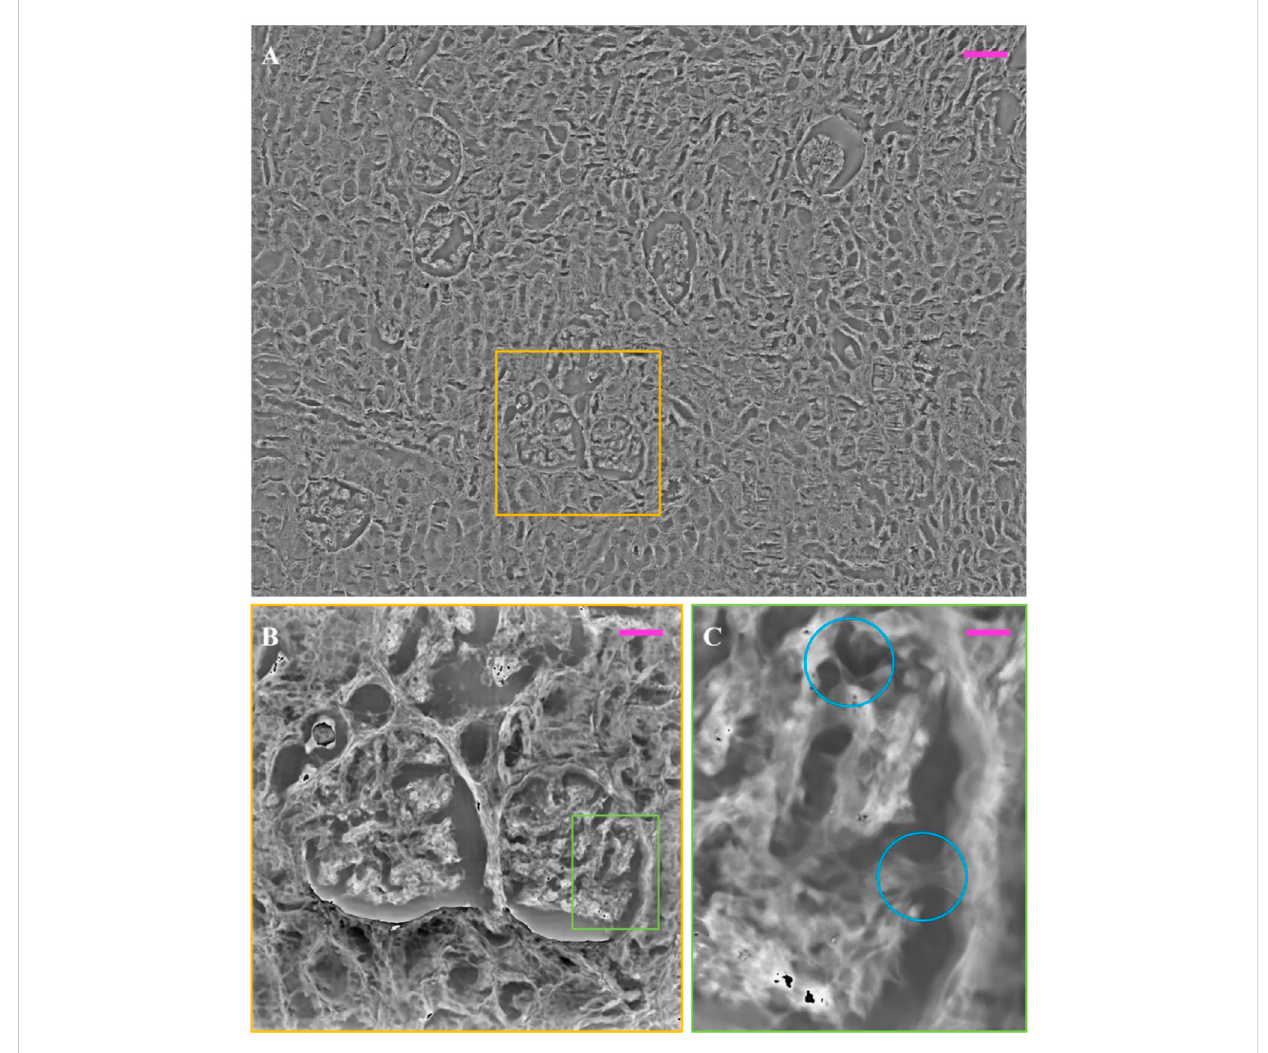
FIGURE 7 Multi-scaled/unstained FP phase image over our FP fi eld of view: (A) FP phase map of unstained renal tissue, captured by FP, 10 µm thick over 3.3 mm 2 ; (B) zoomedglomeruliandtubulessections(yellowbox); (C) zoomofglomerulusinnerstructures(greenbox).Thelightbluecircleshighlightthe basal membranes of the glomerulus. The scale bars are respectively: ~105 ~58, and ~10